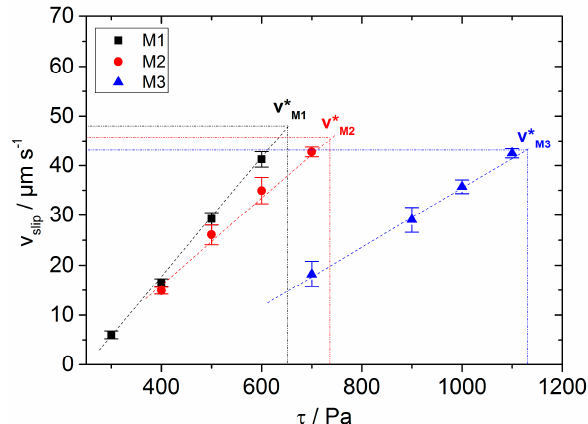
Figure 3. Slip velocity of model pastes on steel rheometer plate with roughness R q = 1 µm as a function of applied shear stress, v slip , determined as described in Section 3.1. The characteristic slip velocity V * occurs at the yield stress of the paste.